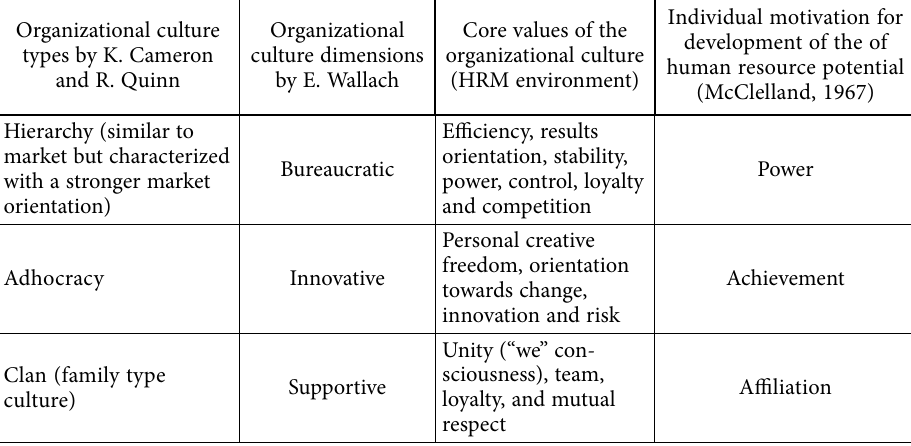
Table 1. Characterization of K. Cameron, R. Quinn and E. Wallach organizational culture types/dimen- sions (source: Dubkevics & Barbars, 2010) Organizational culture types by K.